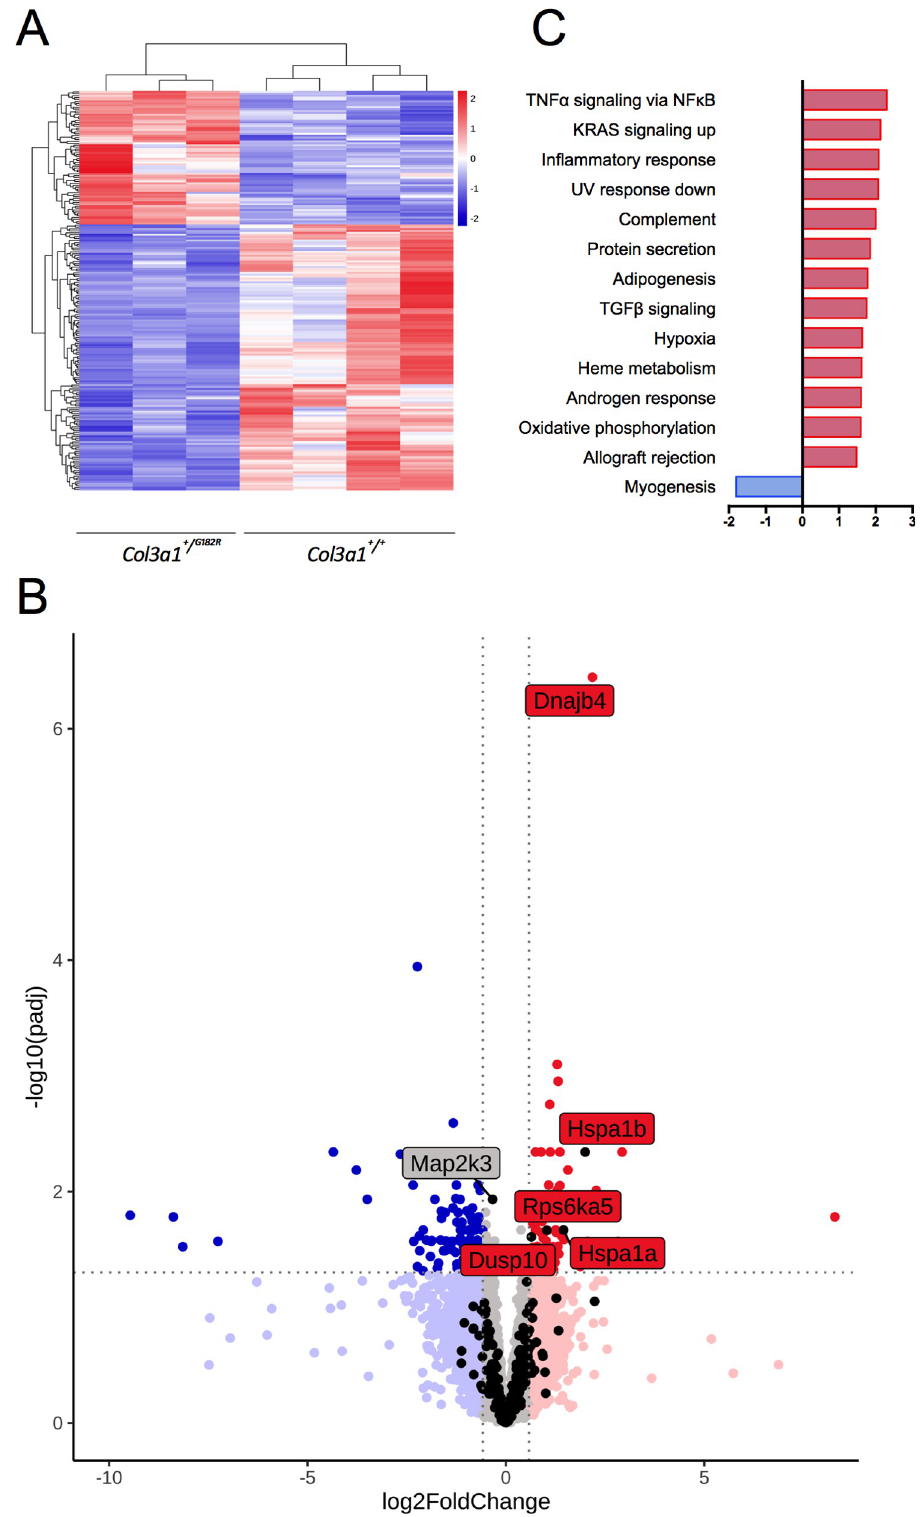
Fig 5. The p.G182R Col31a variation results in inflammation and cell stress response and normal PLC/IP3/PKC/ ERK signaling pathway in TA transcriptome. A Unsupervised hierarchical clustering using the 210